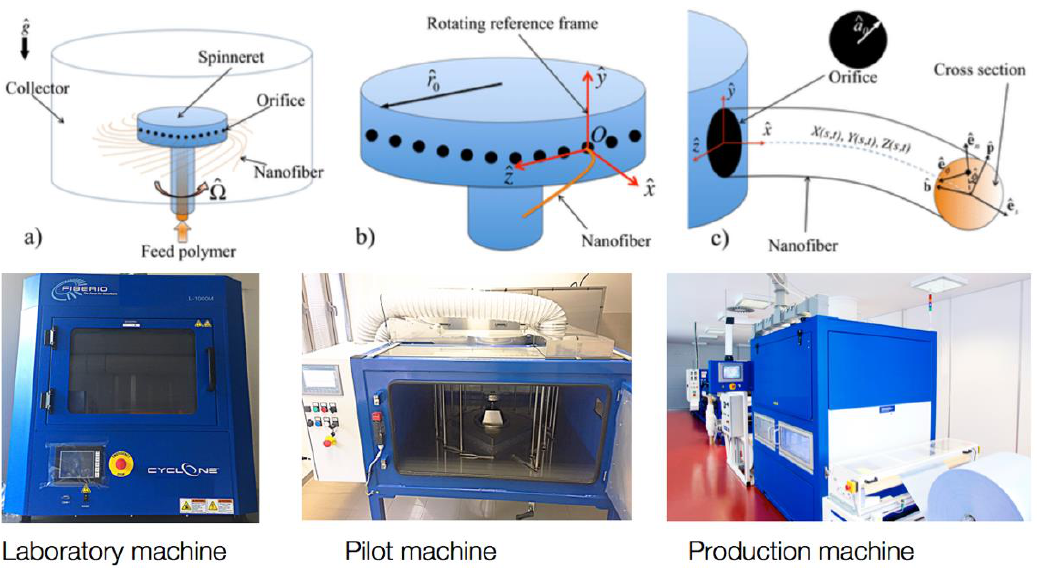
Figure 1. The principle of centrifugal spinning and the particular device that was used by PARDAM, Ltd. (Roudnice nad Labem, Czech Republic) for the preparation of the studied polymer nanofibers samples.